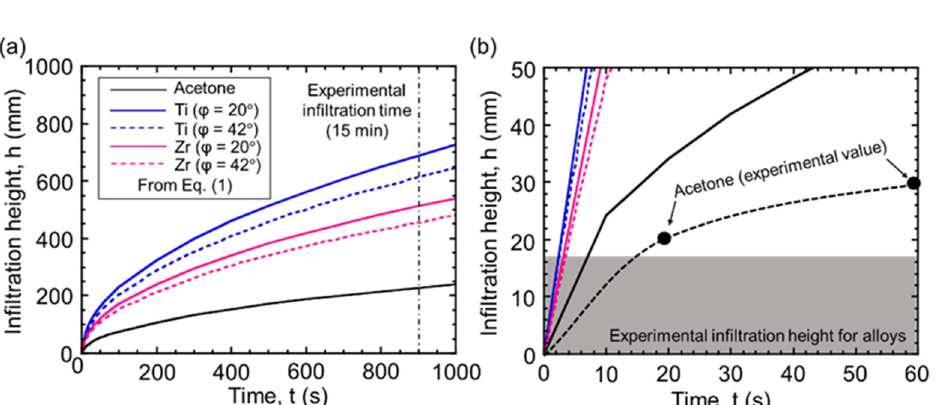
Figure 5. ( a ) Relationship between calculated infiltration height and time. ( b ) Enlarged view of ( a ) along with experimental values.